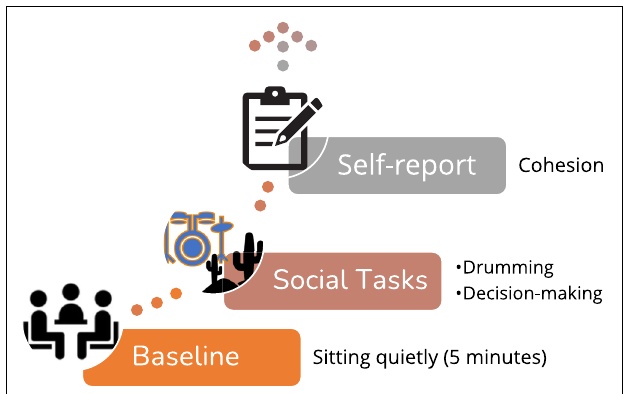
FIGURE 1 | The common phases of the two experiments – “drumming” and “decision